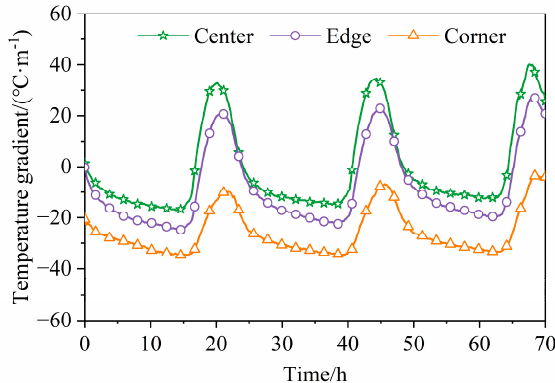
Figure 4. Temperature gradient time history curve of RCP.